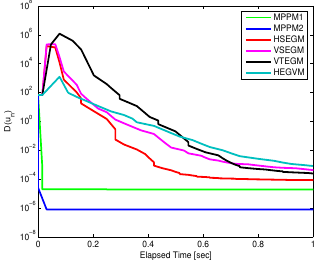
Figure 4. Methods for Example 2 with α n = ( n + 1) − 0 . 9 . Number of iterations is 55, 67, 104, 143, 199, 223, respectively.